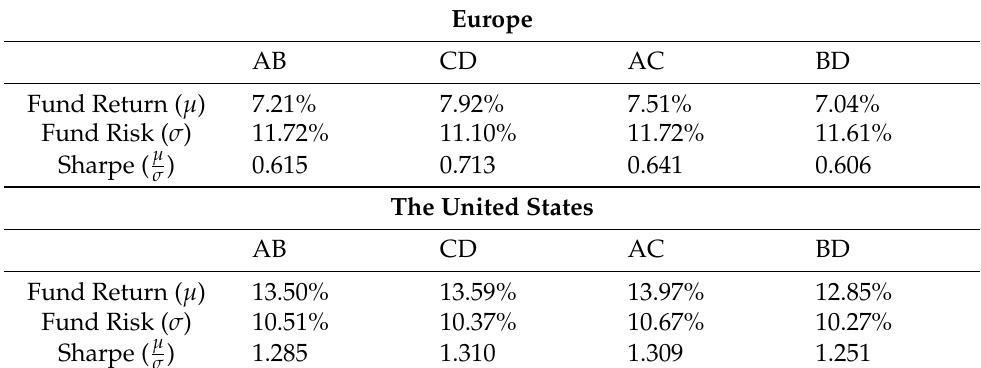
Table 4. Descriptive statistics—Mutual fund